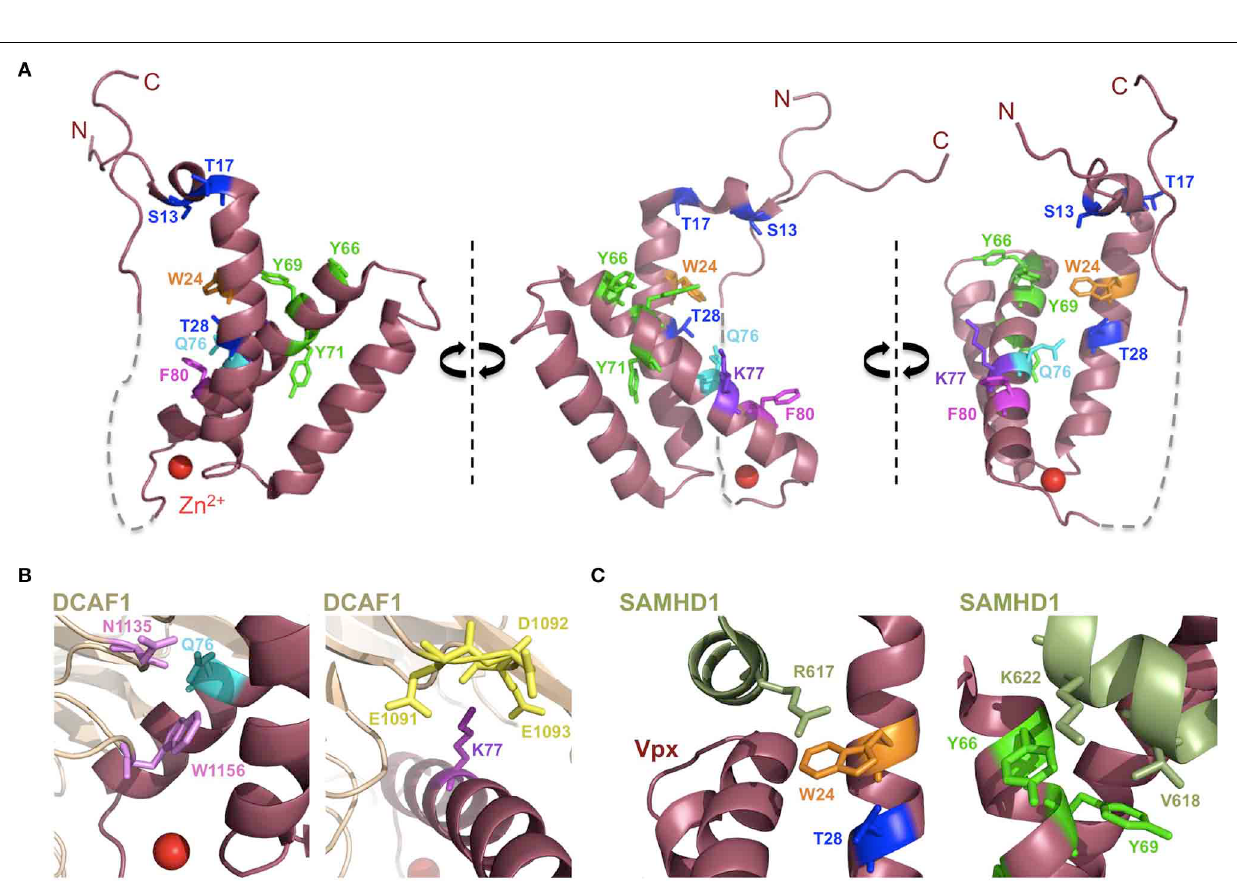
(cyan) may form hydrogen bonds with N1135 and W1156 residues (lilac) of DCAF1. The acidic region in DCAF1 comprising E1091, D1092 and E1093 residues (yellow) may interact with positively charged K77 residue (purple) of Vpx. (C) Critical amino acid residues for the interaction of SAMHD1 and Vpx are highlighted. SAMHD1 R617 residue (light green) stacks with the indole ring of Vpx W24 residue (orange). Vpx Y66 and Y69 residues (fluorescent green) are in close proximity to SAMHD1 K622 and V618 residues (light green), the latter being positively selected (Laguette et al.,